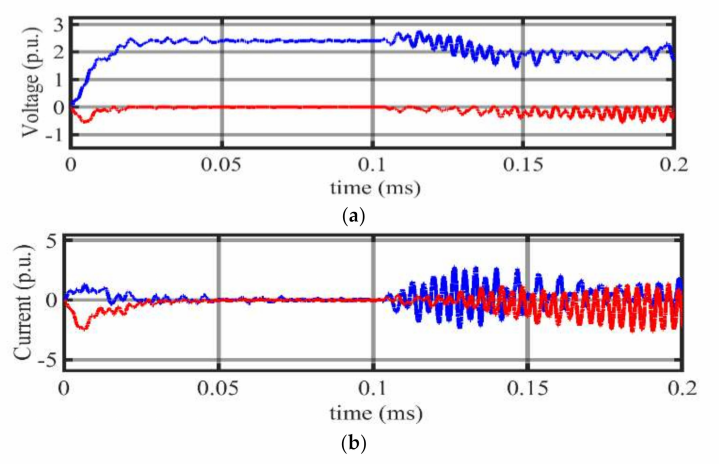
Figure 22. ( a ) DC Voltage and ( b ) DC current measured under NPG fault occurred at 100 km from RS-I on Line